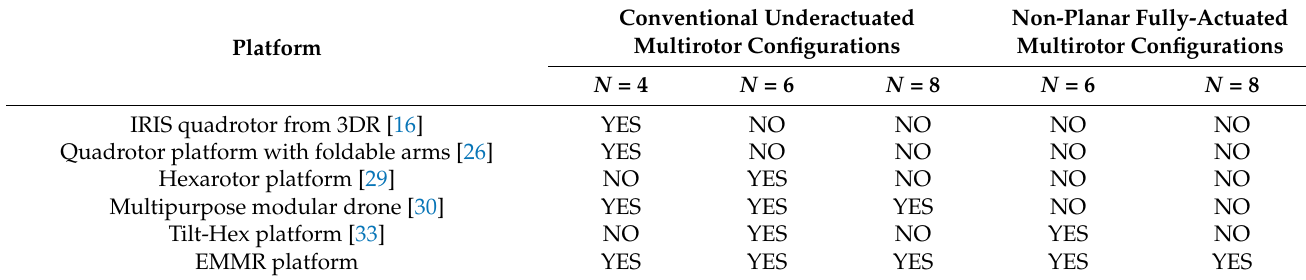
Conventional Underactuated Multirotor Configurations